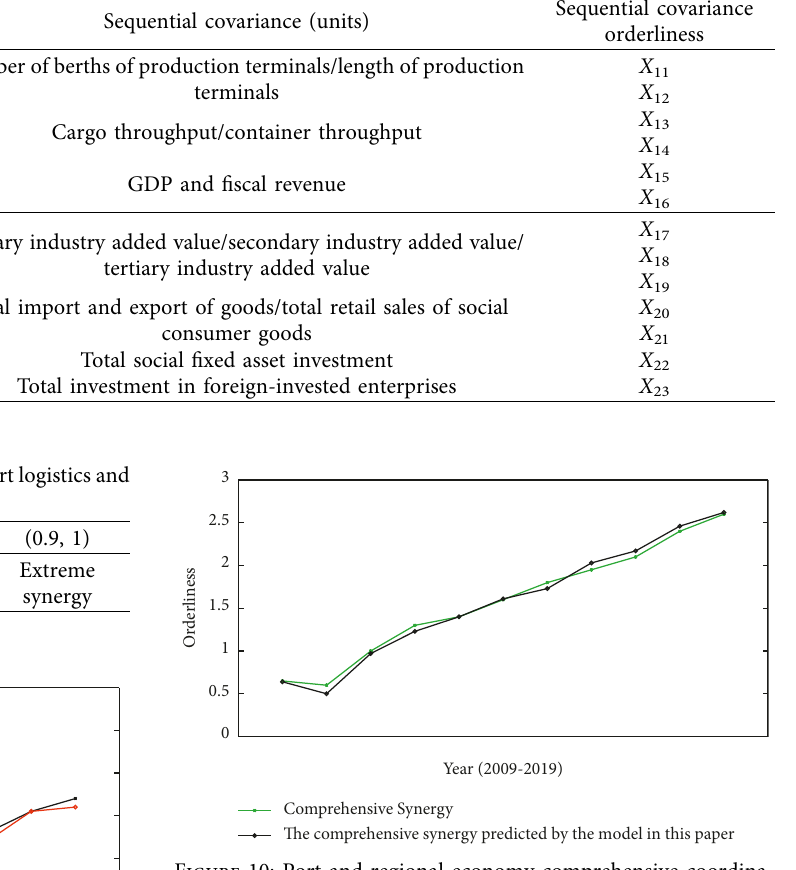
Figure 10: Port and regional economy comprehensive coordina- tion